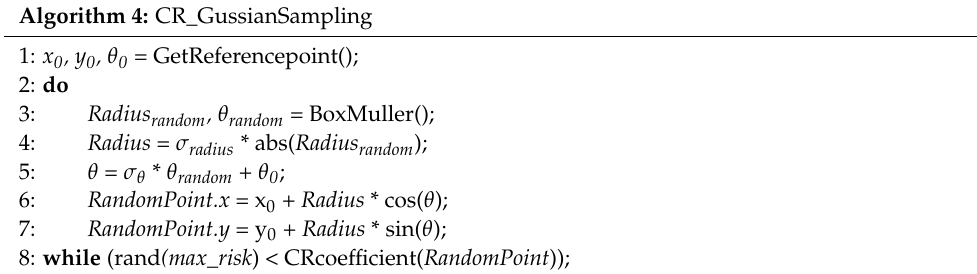
Figure 8. Road environment containing obstacles.